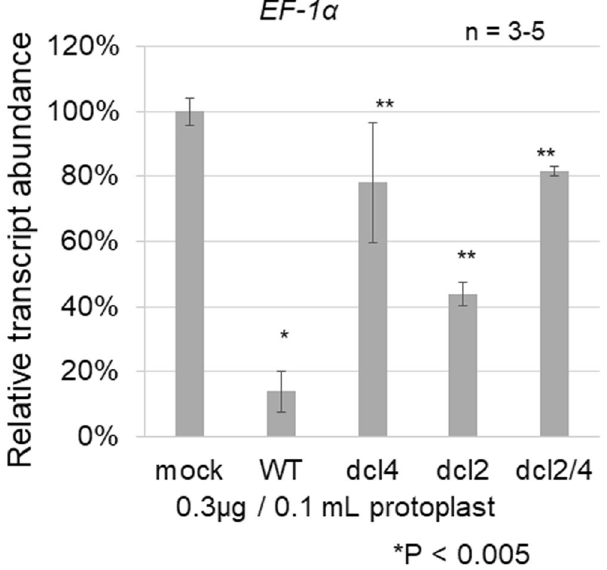
Figure 6. Efficiency of RNAi in dcl mutants. A 0.1-mL volume of protoplasts (10 6 to 10 7 cells/mL) prepared from Arabidopsis WT or dcl mutant seedlings were transfected with 0.3 µ g of 139-nt EF-1 α dsRNA. Protoplasts were collected 2 days after transfection, and then the abundance of EF-1 α transcripts in transfected protoplasts relative to that in mock-transfected protoplasts (100%) was determined by qRT-PCR and normalized to the level of ACT2 transcripts. Error bars indicate the standard error of three to five biological replicates, and p-values were determined using the Student’s t -test. Single asterisk ( * ) indicates significant difference between mock- and 139-nt dsRNA-transfected WT protoplasts, and double asterisks ( ** ) indicate significant differences between WT and the three mutant